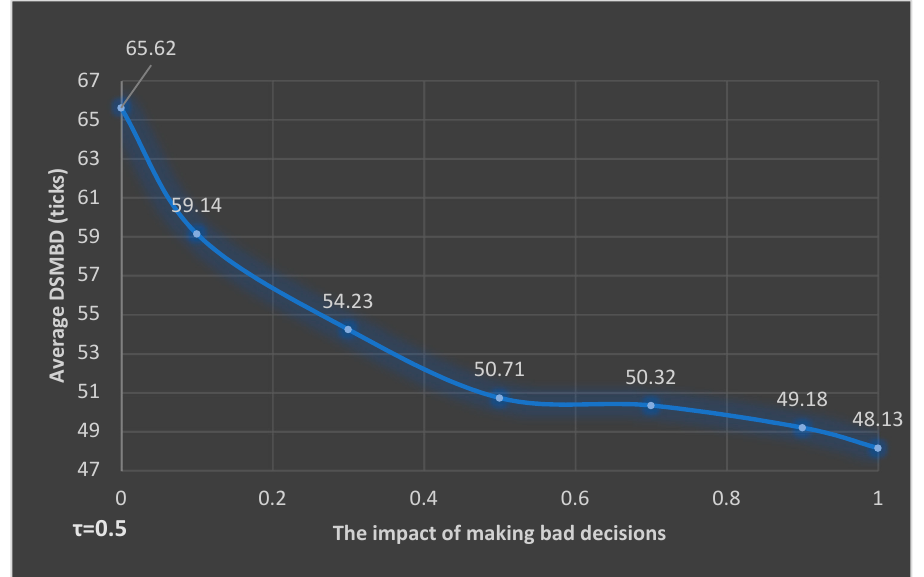
Figure 8. Average DSMBD versus the tolerance for manager’s performance, when bd = 0.1 and S2 is considered.